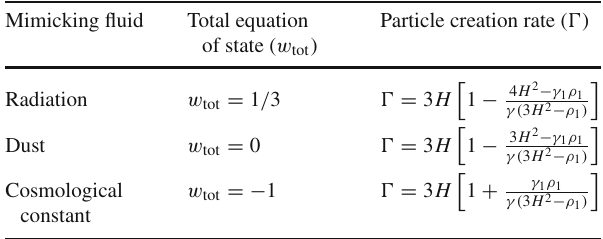
Table 1 The table presents different particle creation rates correspond- ing to different effective fluids Mimicking fluid Total equation